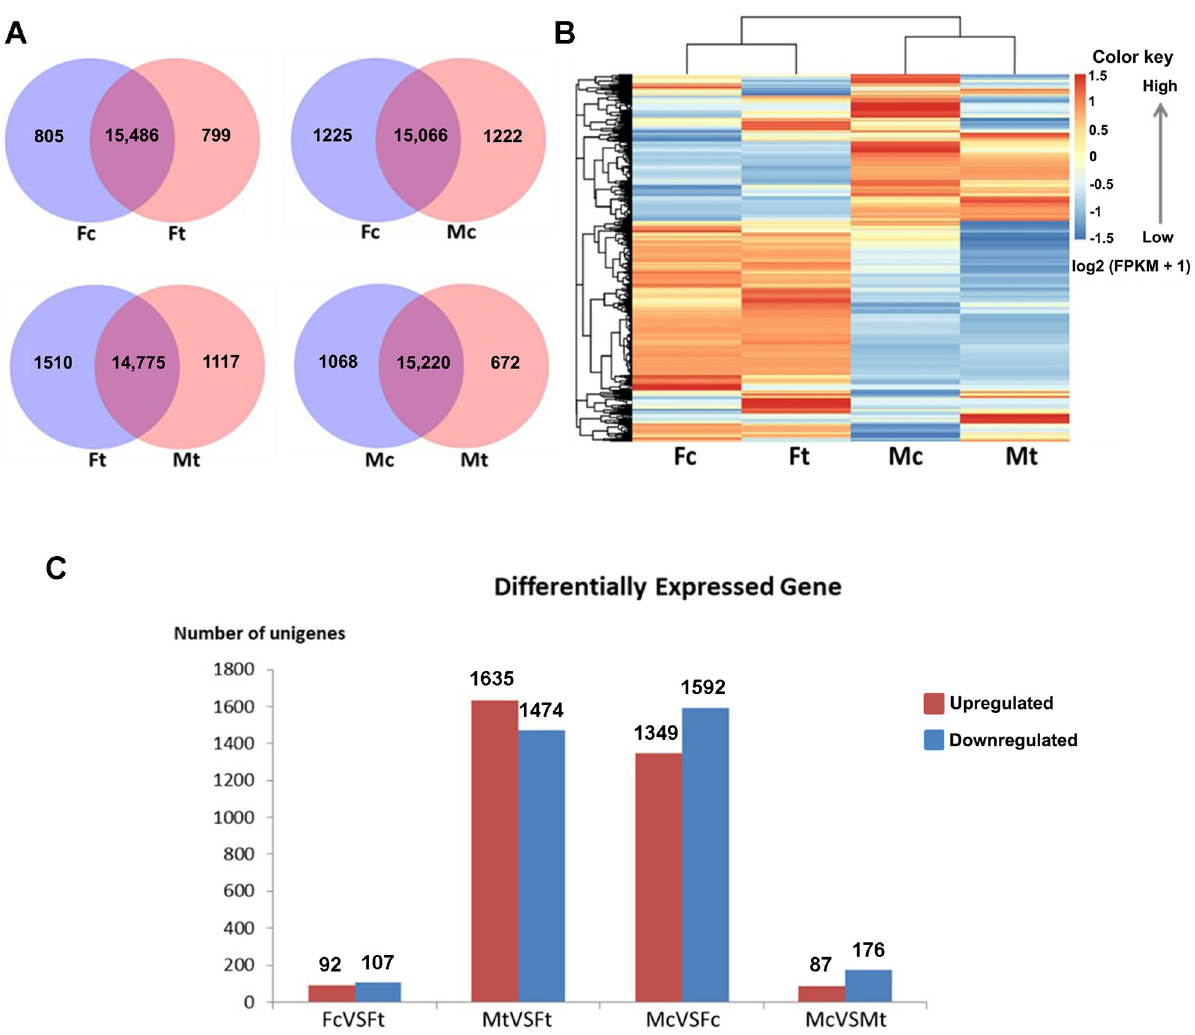
Fig 1. Differential gene expression pattern of free-living adult S . stercoralis based on the de novo assembly. ( A ) Venn diagram showing the number of unique and shared expressed genes among samples. ( B ) Expression profiles of all expressed unigenes are represented in the heatmap, where red and blue indicate higher and lower expression levels, respectively. To construct the heatmap, raw FPKM values were log 2 -transformed after a value of 1 was added to the raw value to avoid log 2 (0). ( C ) DEGs were defined as a unigene with log 2 -fold change > 3.00 or < -3.00 and FDR < 0.001. DEGs with higher expression levels in Ft than in Fc (FcVSFt), Ft than in Mt (MtVSFt), Fc than in Mc (McVSFc), or Mt than in Mc (McVSMt) were defined as “Upregulated”; those with lower expression levels were defined as “Downregulated” (Fc = female control, Ft = female DXM treated, Mc = male control, Mt = male DXM